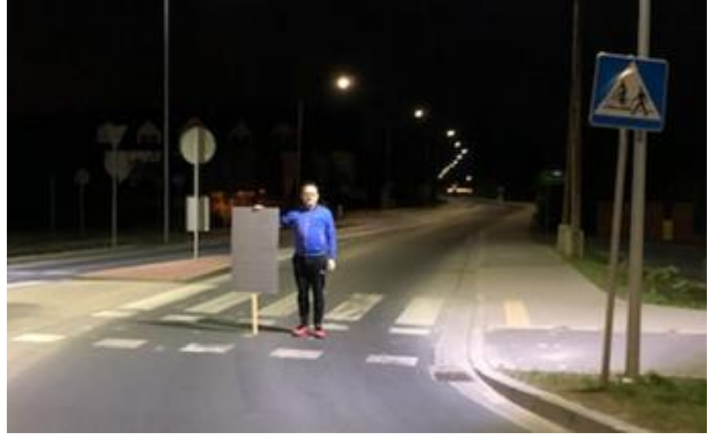
Figure 8. The board used for